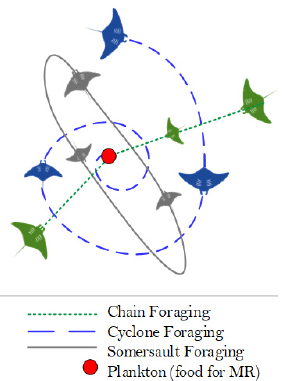
Figure 3. Foraging behavior of the manta rays.